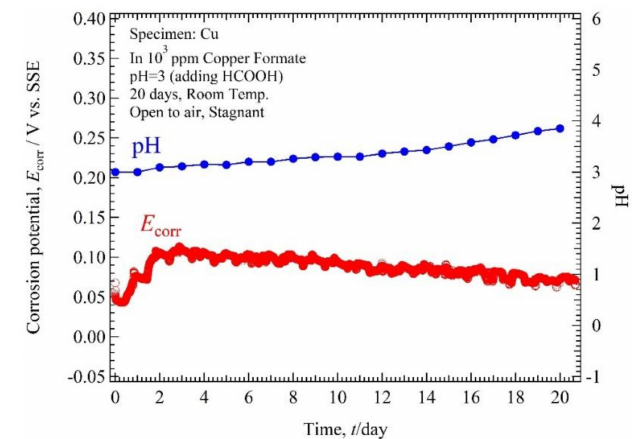
Figure 7. Corrosion potential, solution pH and time plot of Cu tube specimen in 10 3 ppm Cu(HCOO) 2 solution with solution pH